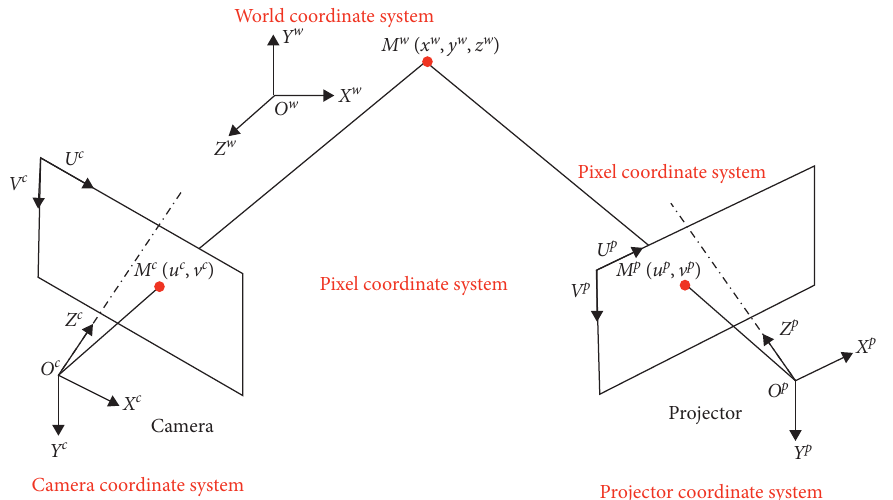
Figure 1: The coordinate system of the phase-shifted fringe projection system.